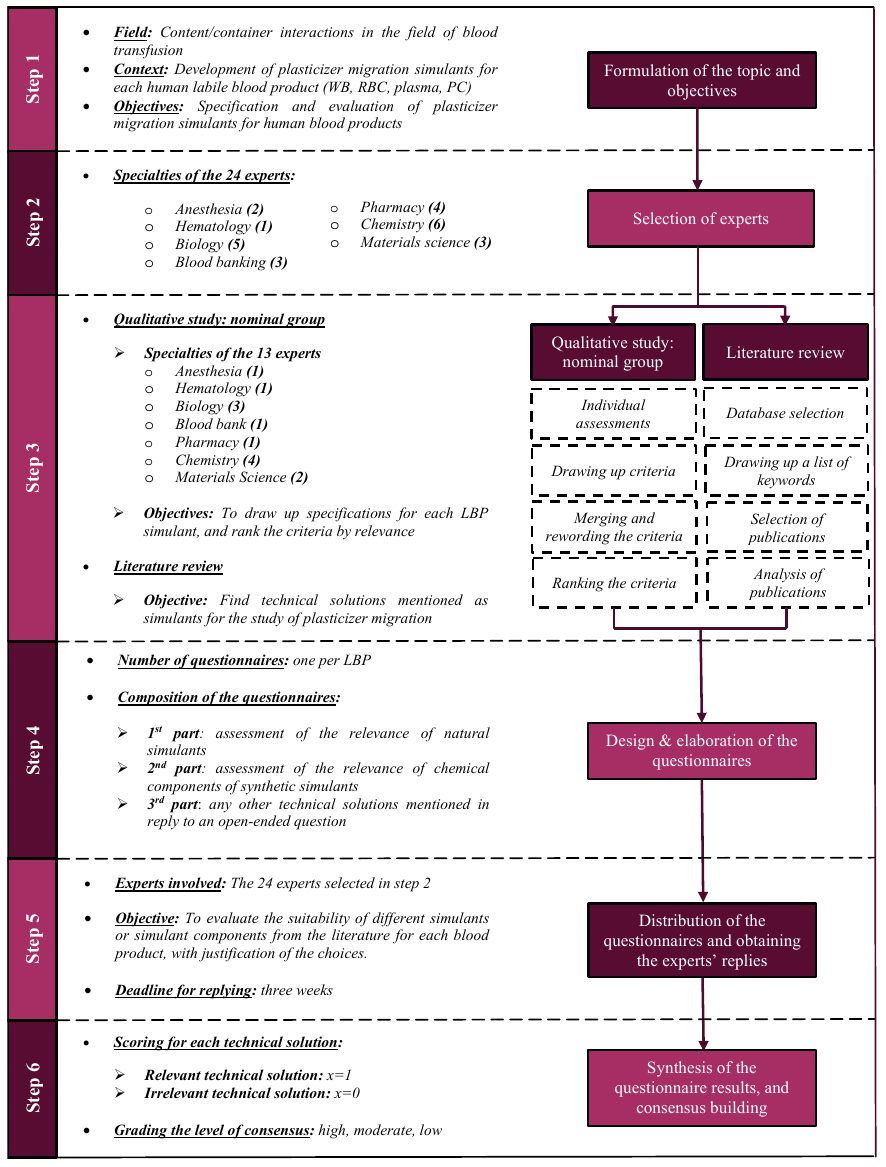
Figure 1. The Delphi method. LBP: labile blood product; WB: whole blood; RBC: red blood cell concentrate; P: plasma; PC: platelet concentrate.